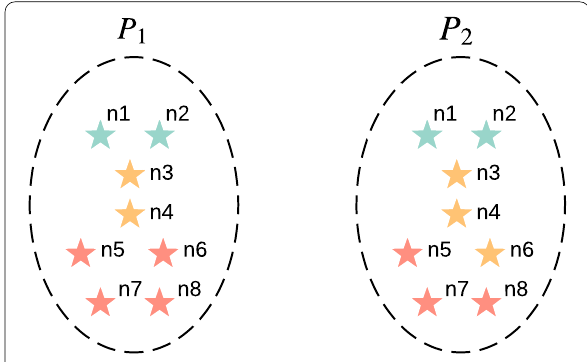
Fig. 2 An example of calculating Rand Index between P 1 and P